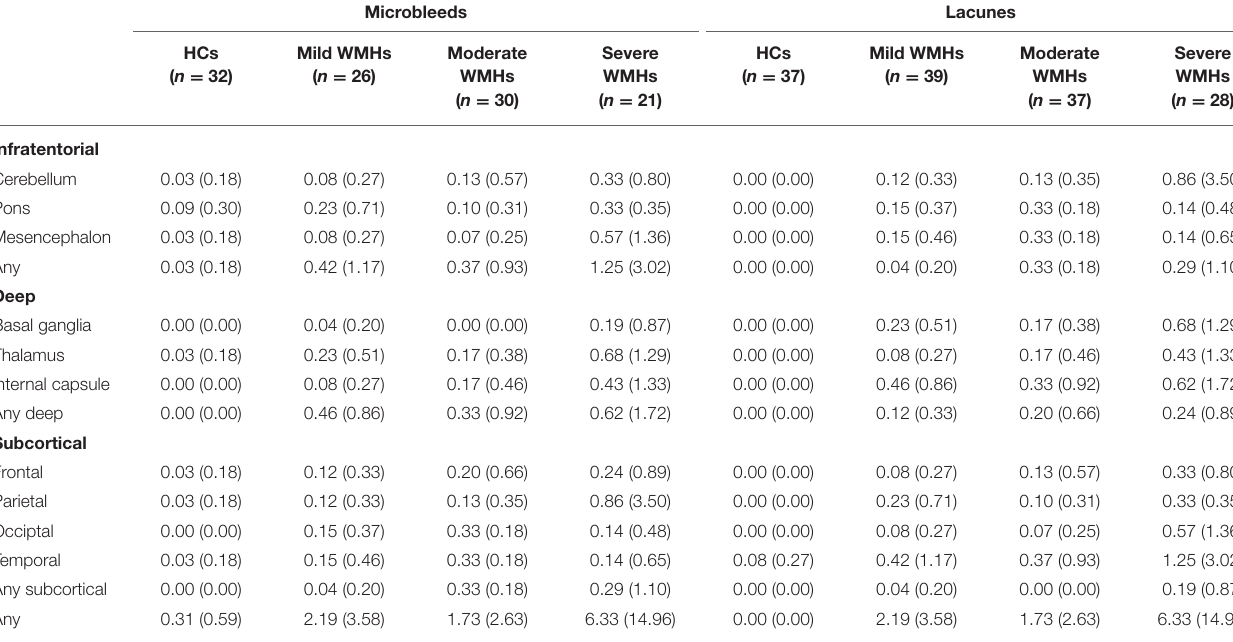
TABLE 2 | Distribution of neuroimaging manifestations in HCs and WMHs [Mean (SD)].